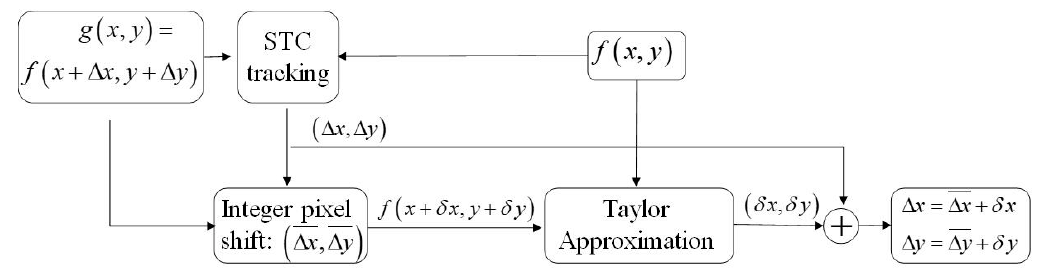
Figure 4. Flowchart of STC-based subpixel tracking using Taylor approximation.